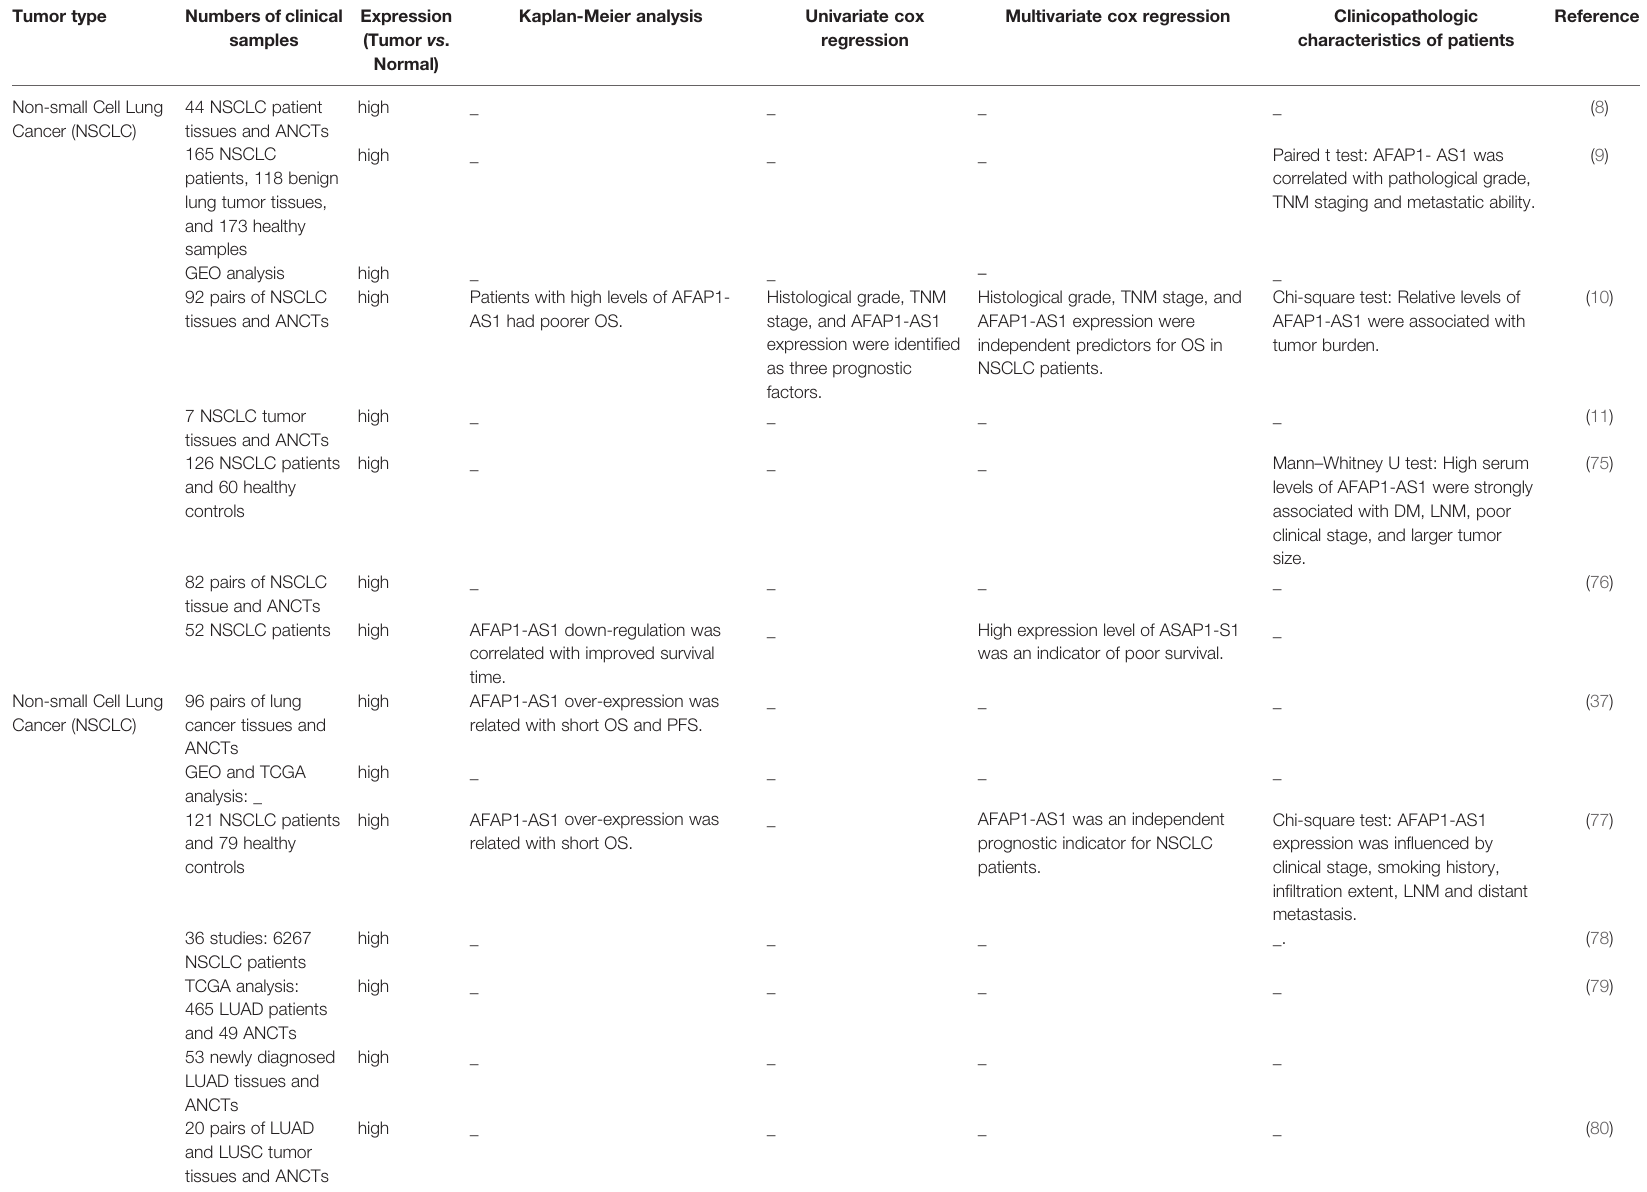
TABLE 3 | Outlines of studies that appraised levels of AFAP1- AS1 in clinical setting. Tumor